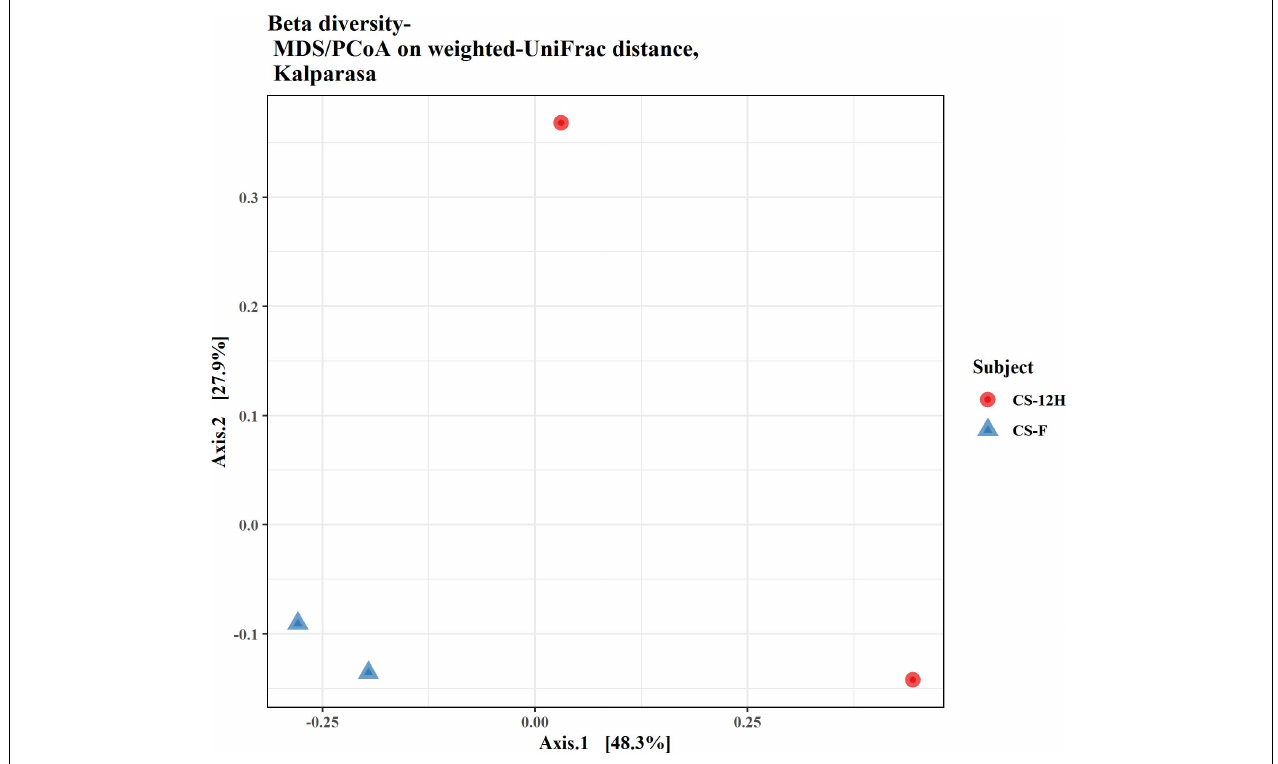
FIGURE 8 | Beta diversity/dissimilarity unifrac distance measure and principal coordinate analysis (PCoA) for fungal reads in fresh (CS-F) and fermented (CS-12H) Kalparasa